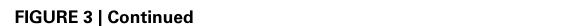
resuspended in SDS sample buffer, and proteins were separated using 12% SDS-PAGE andWestern blotted with anti-mouse ASC antibodies as